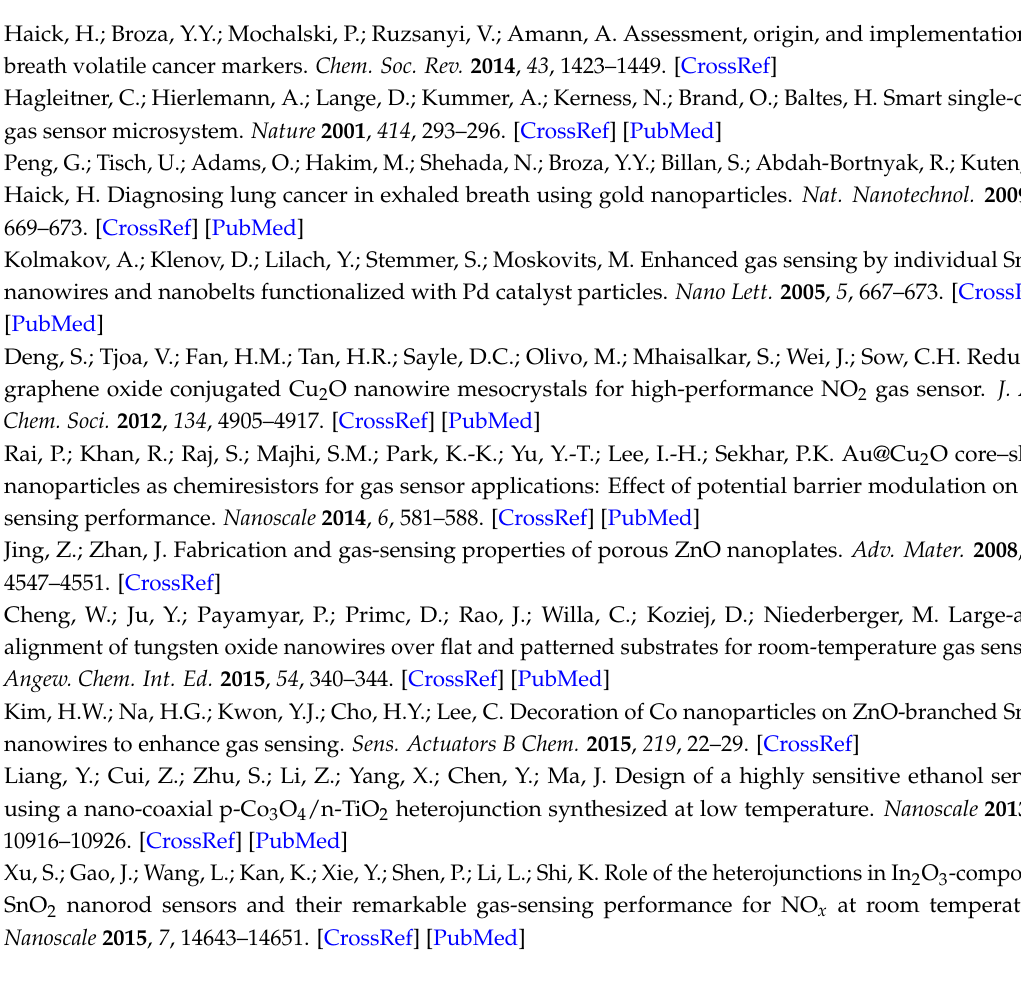
Figure S1: Response of WN/WO 3 composites sensor at RT upon exposure to 200 ppb NO 2 concentration at various relative humidities (RH), Figure S2: Response of the sensor based on WO 3 nanosheets to 100 ppb NO 2 as a function of the operating temperature, Figure S3: Resistances of the sensors based on WN and WO 3 to 100 ppb NO 2 at room temperature, Calculation of theoretical limit of detection using signal/noise ratio, Figure S4: The schematic illustration of ( a ) gas sensing analysis system and ( b ) gas mixing line